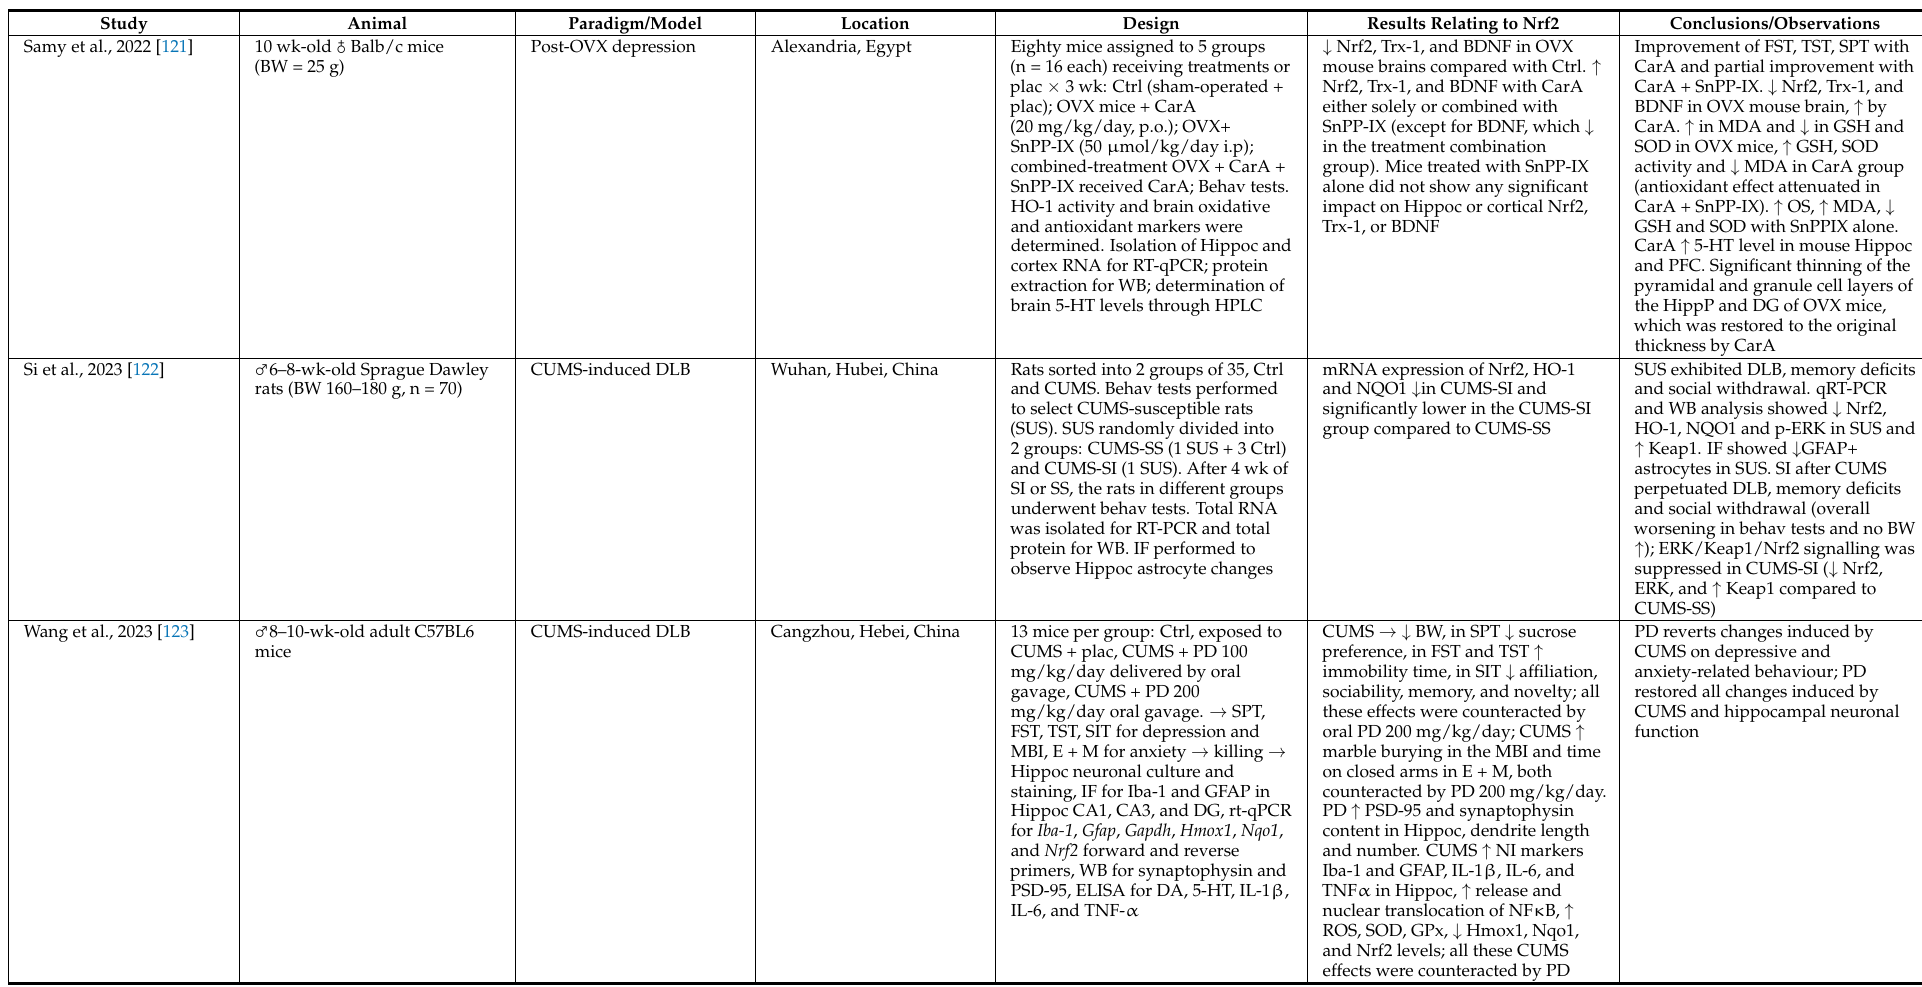
Rats sorted into 2 groups of 35, Ctrl and CUMS. Behav tests performed to select CUMS-susceptible rats (SUS). SUS randomly divided